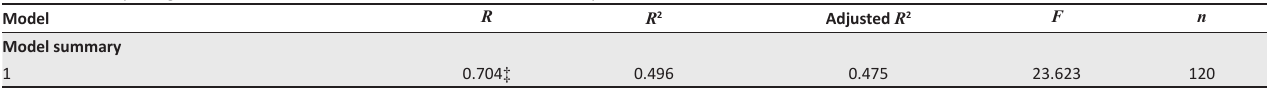
TABLE 5d: Multiple regression results for United Arab Emirates citizens and expatriates.